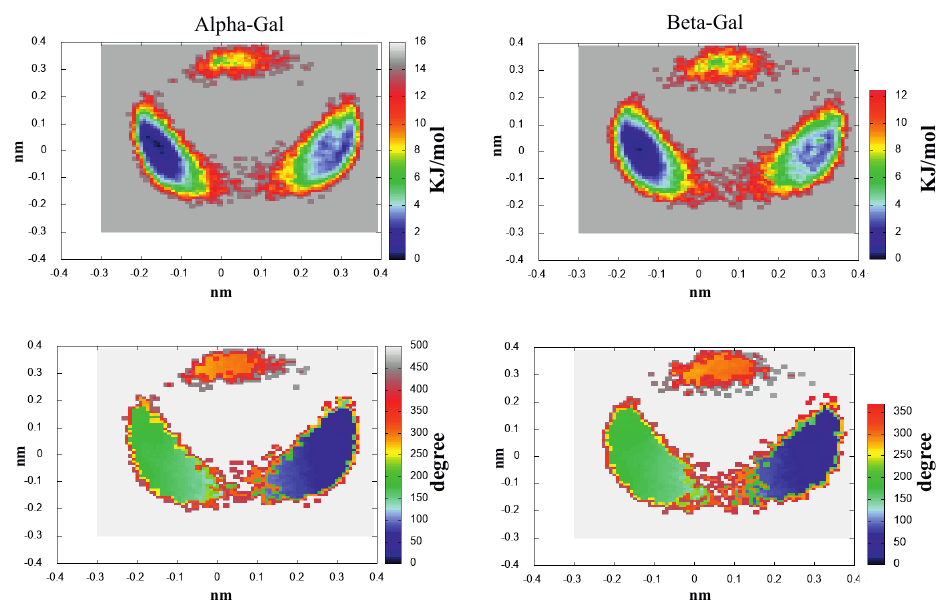
Figure 12. 300 K Helmholtz free-energy variation in the essential plane for Alpha-Gal ( left-upper panel) and Beta-Gal ( right-upper panel). The O6-C-C-O5 torsion angle (mean) value as a function of the essential plane for Alpha-Gal ( left-lower panel) and Beta-Gal ( right-lower panel).